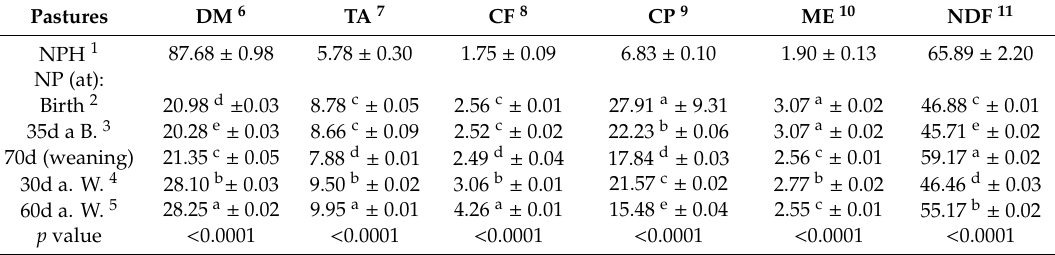
Table 2. Chemical analysis of the pastures during three consecutive measurements.